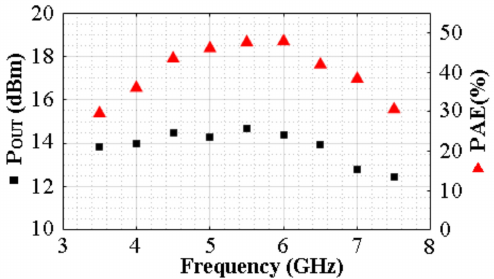
Figure 10. Measured PAE and output power traces versus frequency for the fabricated Class-F − 1 PA.